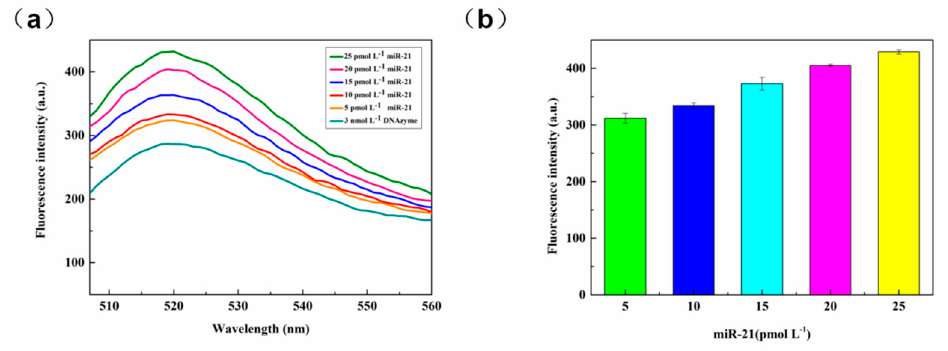
Figure 8. ( a ) Fluorescence spectra for various concentrations of miR-21. ( b ) Plot for the dependence of fluorescence intensity on miR-21 concentration. Error bars indicate five consecutive measurements performed at each concentration (n = 5).